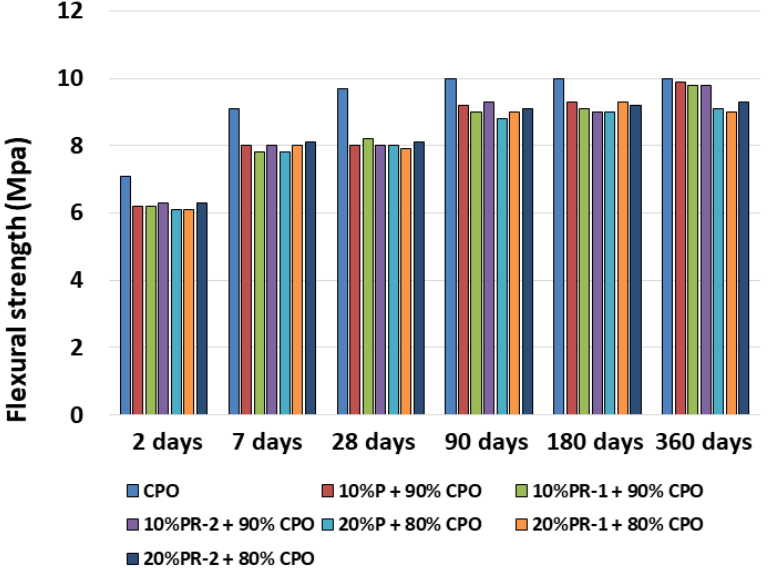
Figure 3. Variation of the flexural strength for all specimens .